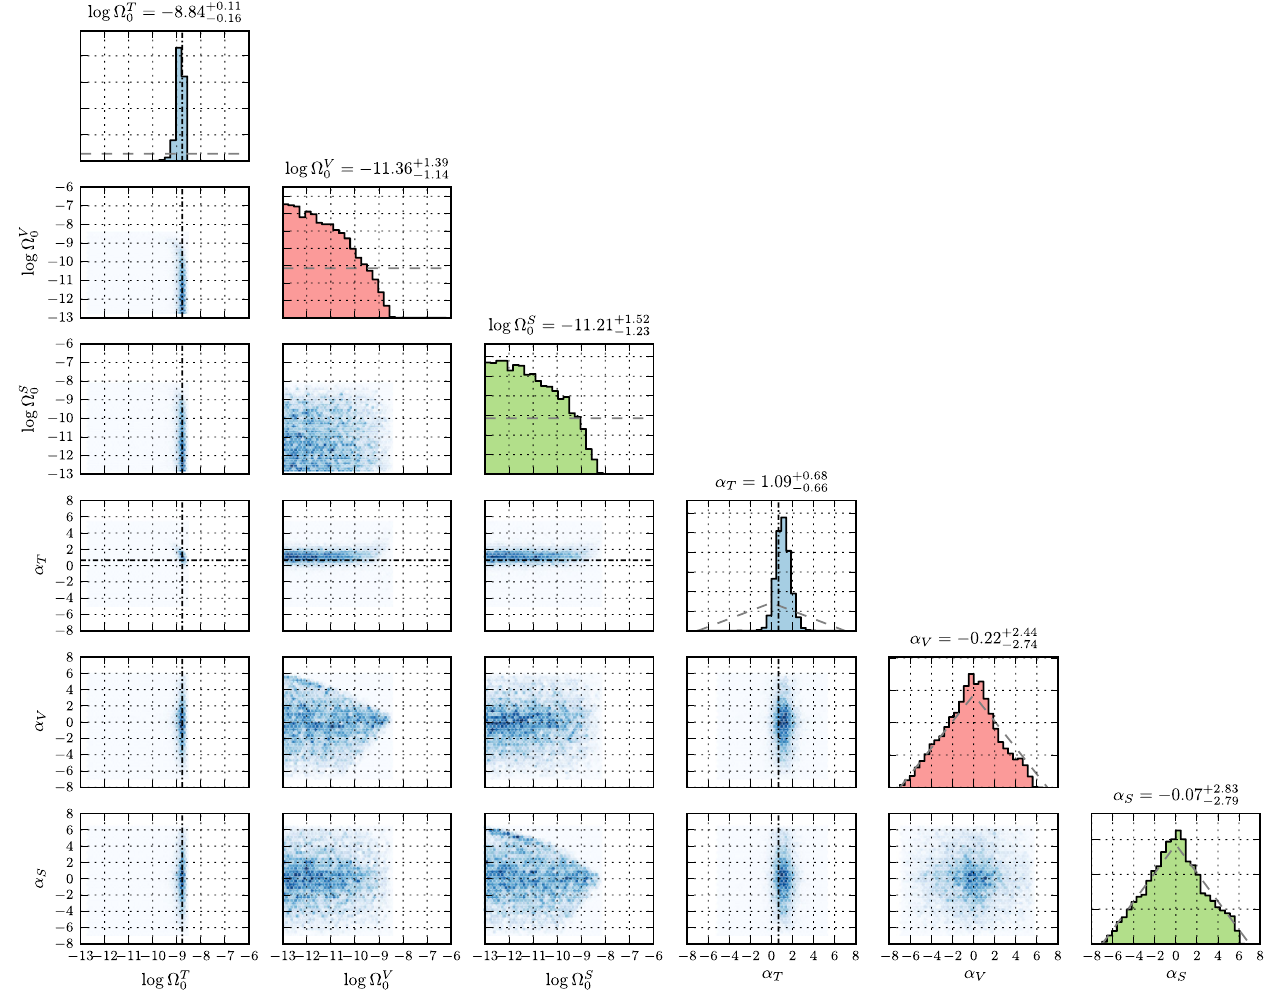
FIG. 12. As in Fig. 10, for a simulated observation of a pure tensor background (case 2 in Table I). The injected tensor amplitude and slope are indicated by dot-dashed black lines. The tensor amplitude and slope posteriors are peaked about their true values. The vector and scalar amplitude posteriors, meanwhile, are consistent with our lower prior bound.